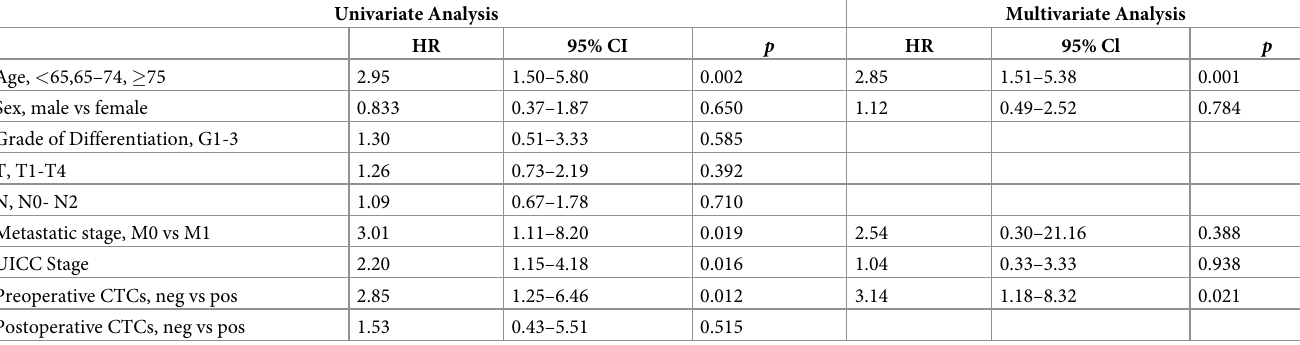
Table 3. Univariate and multivariate analysis of overall survival in patients with